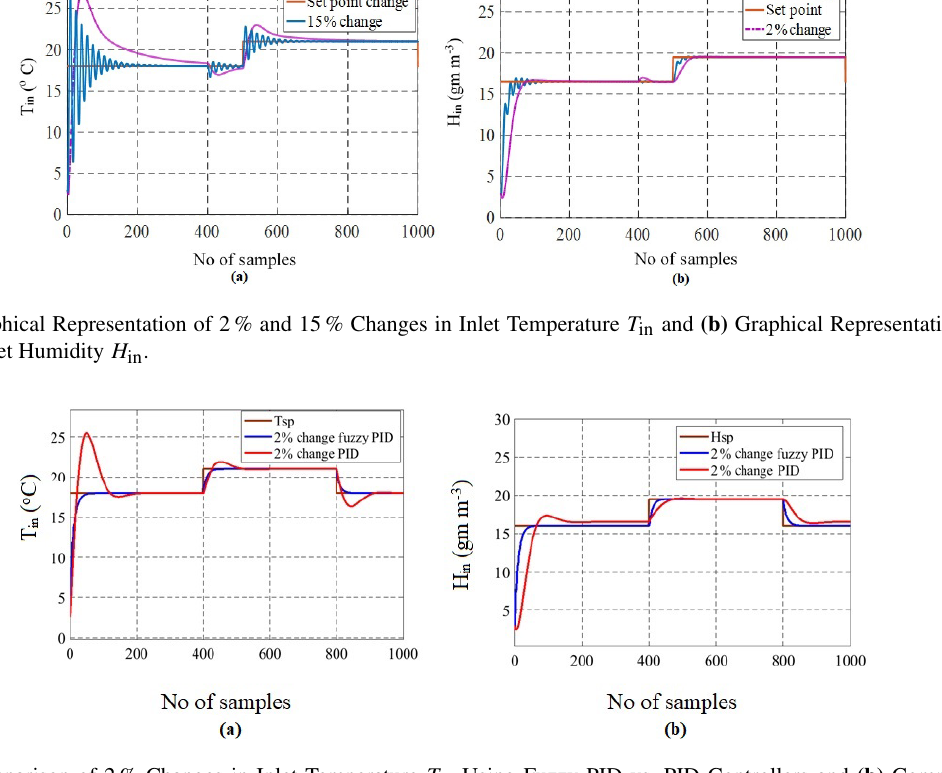
Figure 19. (a) Comparison of 2% Changes in Inlet Temperature T in Using Fuzzy PID vs. PID Controllers and (b) Comparison of 2% Changes in Inlet Humidity H in Using Fuzzy PID vs. PID